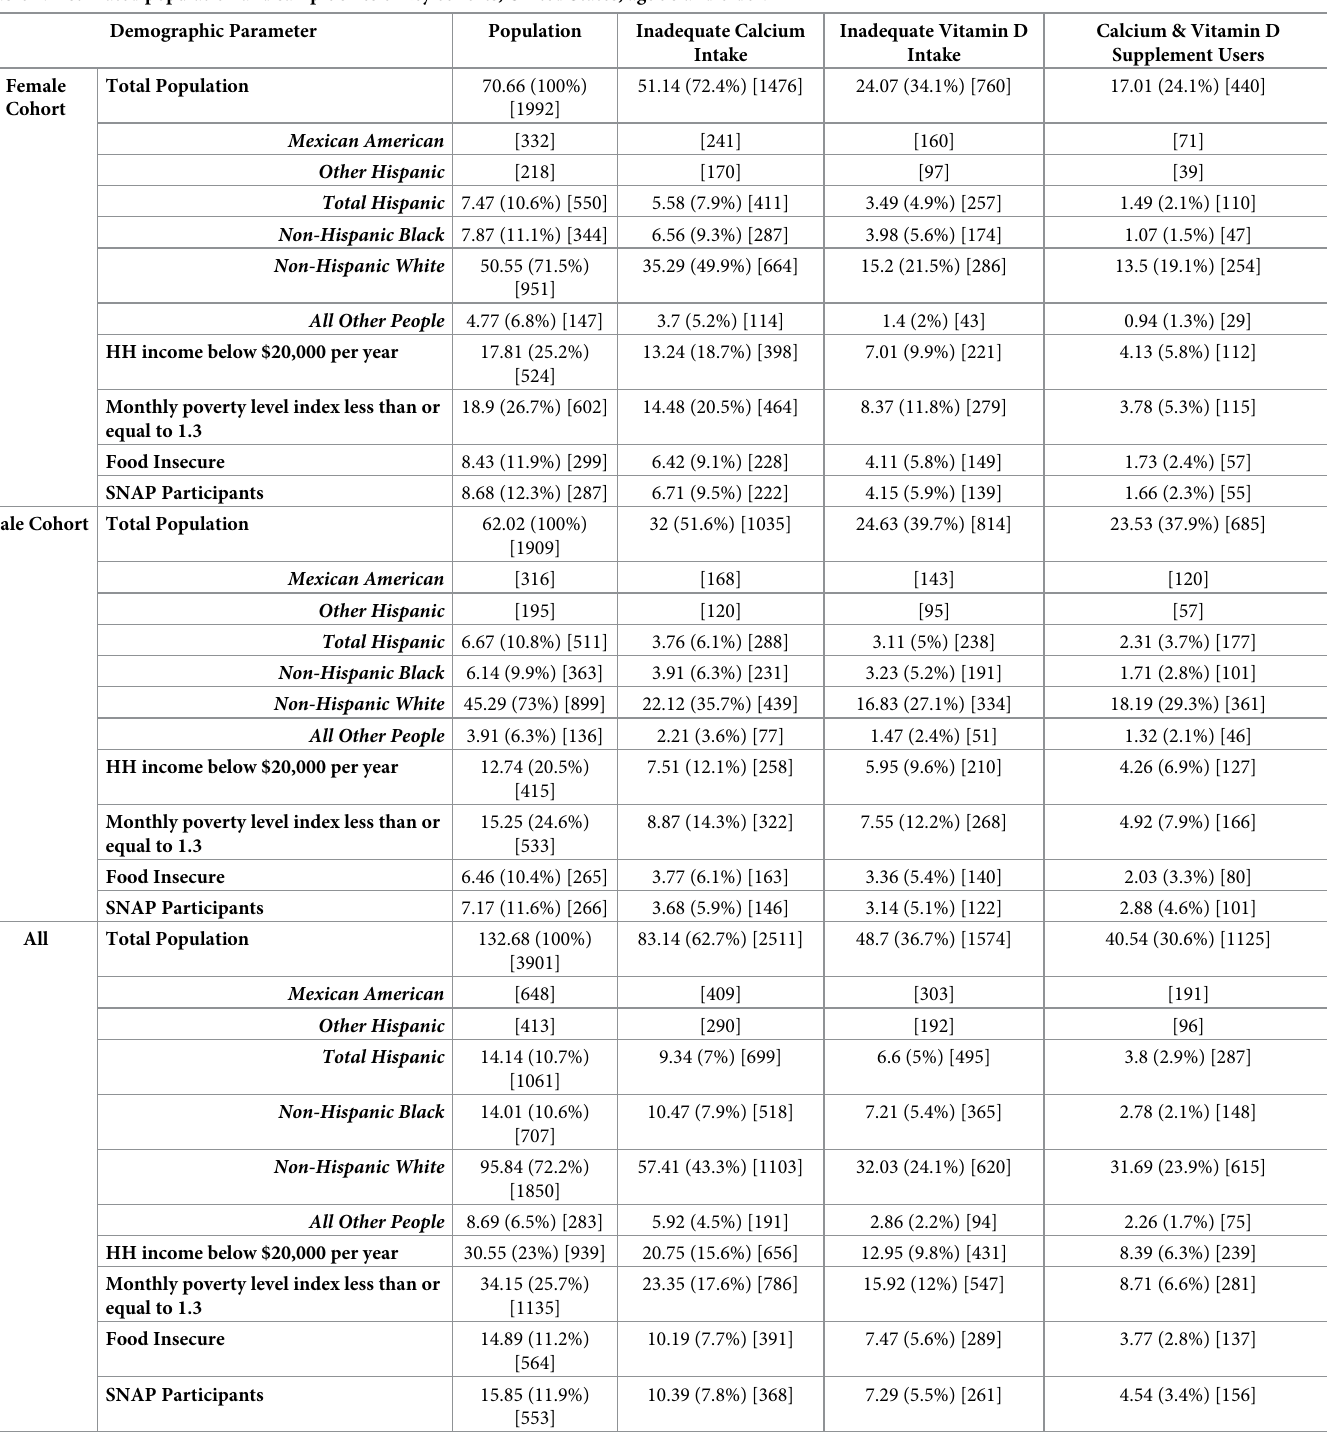
Table 1. Estimated population and sample sizes of key cohorts, United States, age 50 and